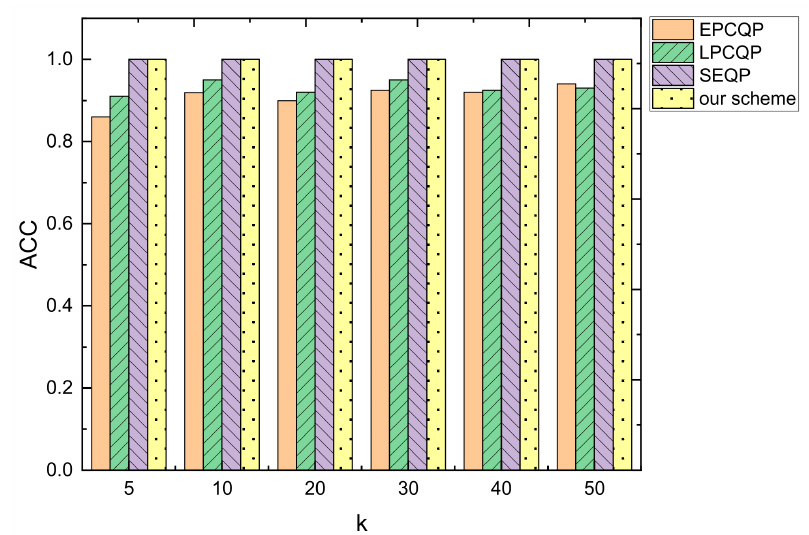
Figure 7. Query accuracy in a real dataset.